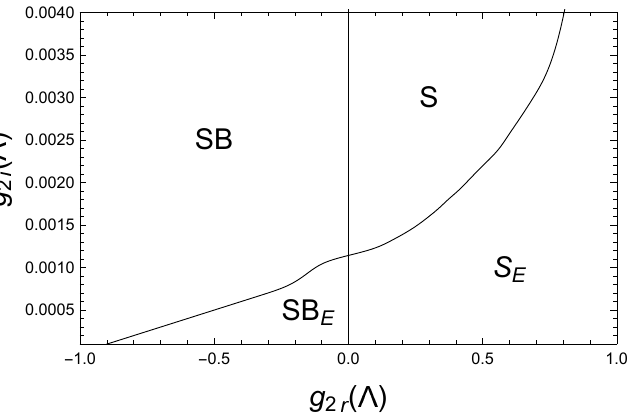
Figure 5. The phase structrure on the complex g 2 ( Λ ) plane at g 4 ( Λ ) = 0.1, h 11 ( Λ ) = − i 2 g 11 i ( Λ ) , h 22 ( Λ ) = 0 and η = 1, S: symmetrical phase, SB: symmetry broken phase and the entengled phases with the subscript E